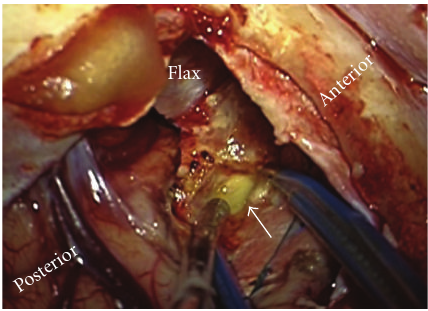
Figure 2: Intraoperative photo post right frontal craniotomy crani- otomy demonstrating the abscess at the anterior frontal above the ethmoid sinus (arrow).